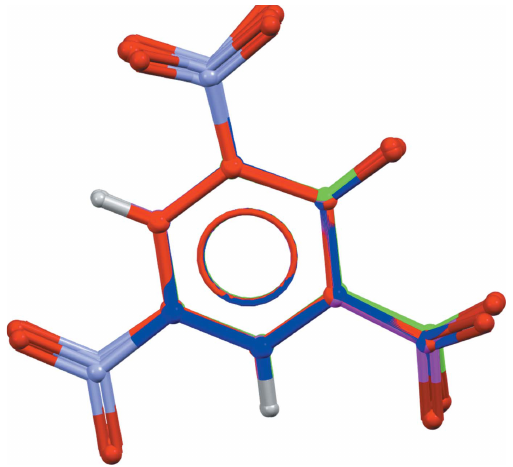
interactions (8) motifs. The 2 (6) motif. 1